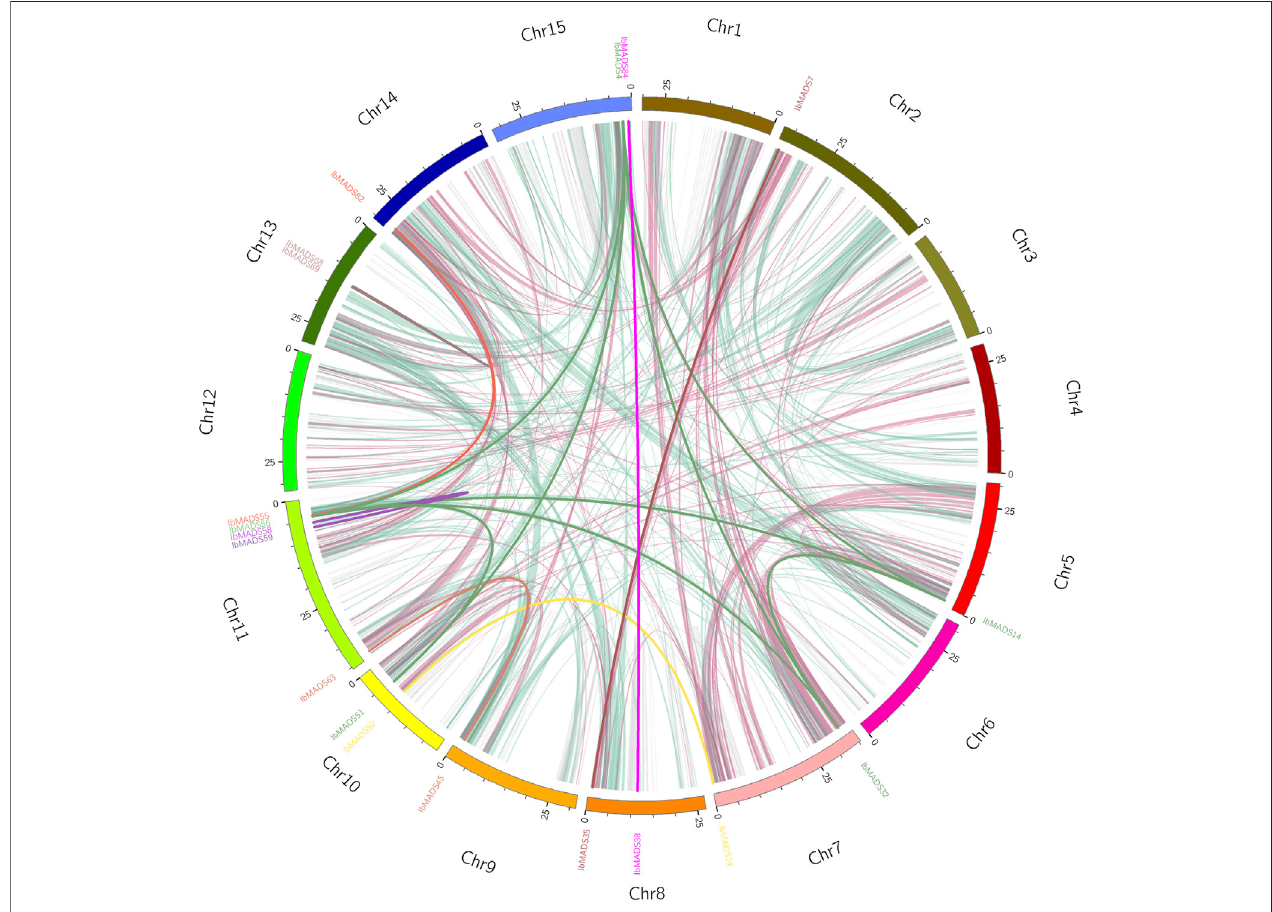
FIGURE 6 | Collinearity analysis of MADS-box gene in sweet potato. The same color name indicates that the gene has a tandem repeat.